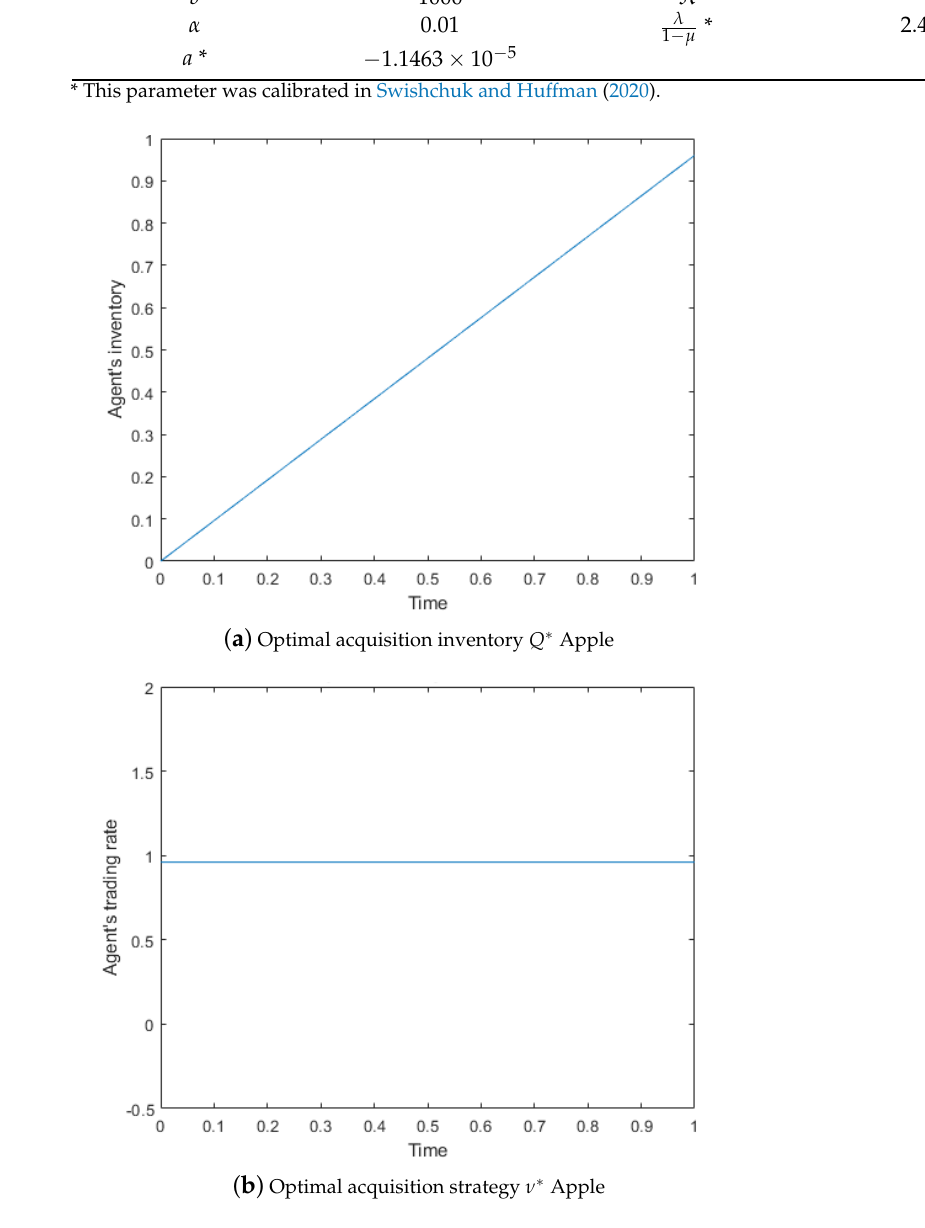
Figure 5. Optimal acquisition inventory and optimal acquisition strategy for Apple stocks. ( a ) the inventory calculated with Equation (56), using the parameters in Table 5. ( b ) the optimal acquisition value calculated with Equation (57), using the parameters in Table